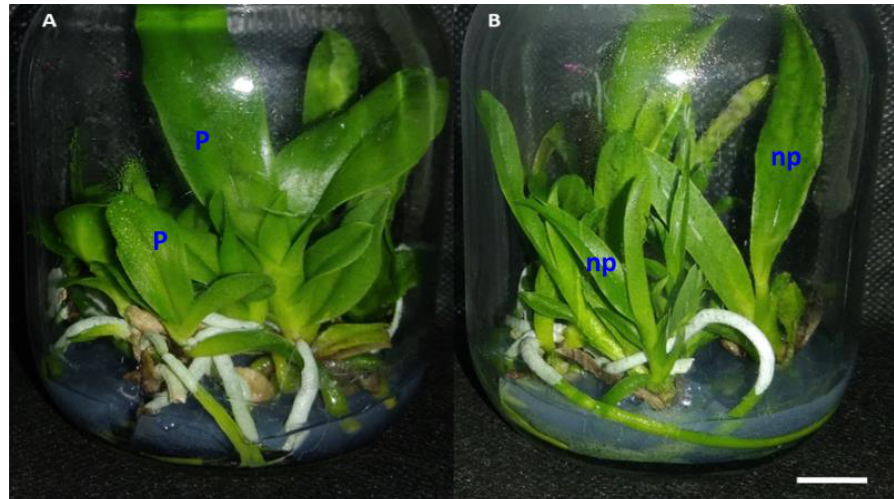
Figure 5. Development and in vitro rooting of plantlets regenerated from protocorm explants treated and not treated with colchicine: ( A ) vial containing only polyploid plants (P) of the progeny from Blc . Haw Yuan Beauty × Blc. Goldenzelle “LC”; ( B ) vial containing non-polyploidized plants (np) of the progeny from Blc. Haw Yuan Beauty × Blc. Goldenzelle “LC” and not treated with colchicine. Scale bar = 1 cm.